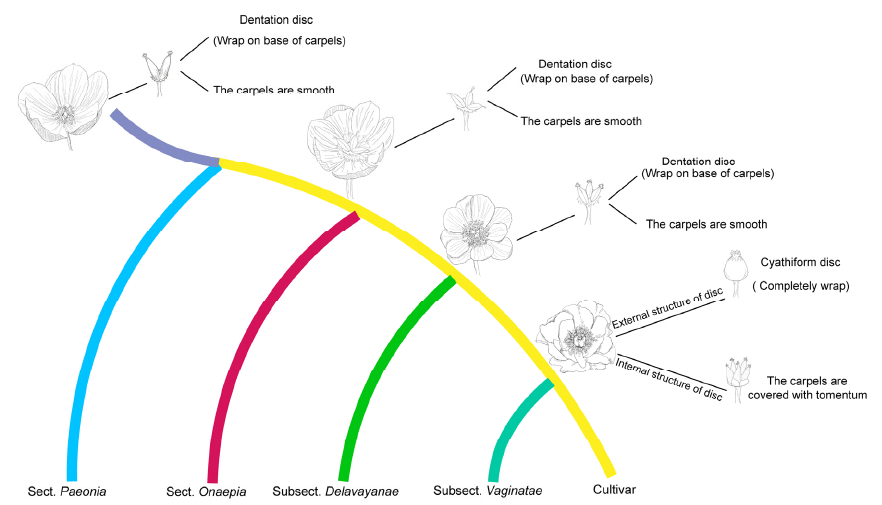
predicted the representative flower types of the four evolutionary node species of Paeoniaceae. The evolution of floral organs mainly focuses on the shape and number of petals, the characteristics of disc and the number of carpels.